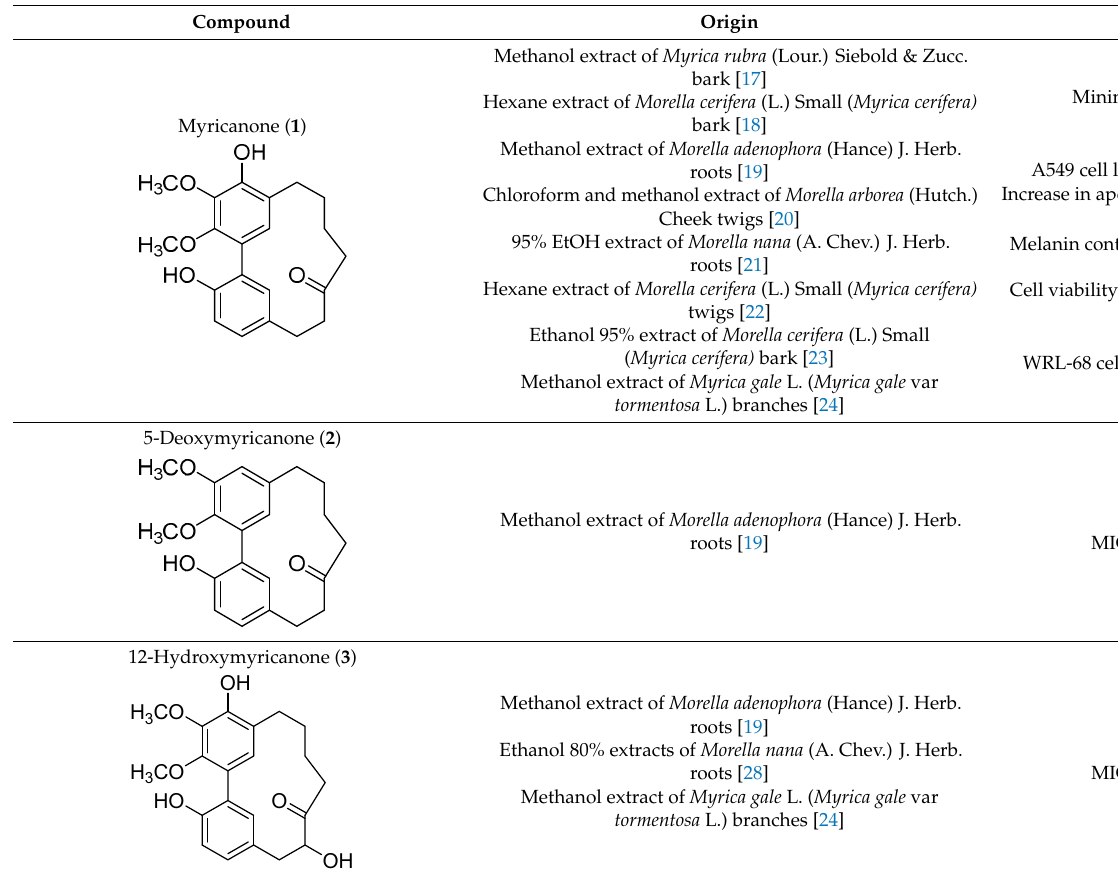
Table 1. In vitro biological activities exhibited by compounds from Morella and Myrica species.